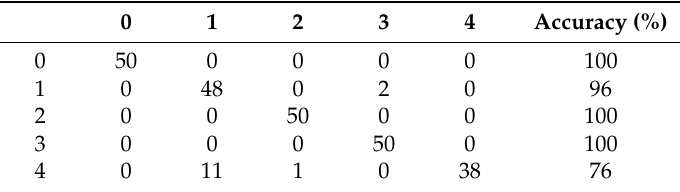
Figure 10. Illustrations of head pose orientation. Table 4 . Head pose detection experimental results.